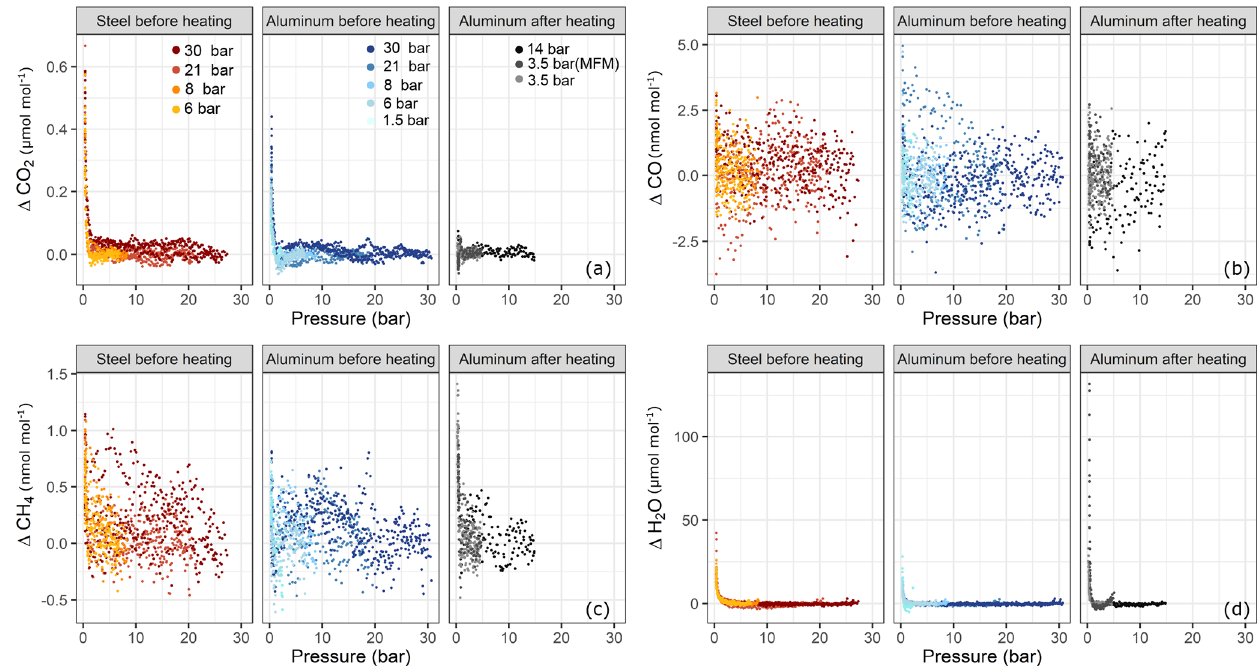
Figure 6. Amount fraction differences relative to the starting amount fractions during the course of each experiment with respect to pressure for (a) (cid:49) CO 2 , (b) (cid:49) CO, (c) (cid:49) CH 4 and (d) (cid:49) H 2 O. The subplots are grouped according to cylinder material and cylinder property: steel and aluminum before heating and aluminum after heating (Table 1b, f, h). Each subplot contains a set of pressure steps denoted by different colors. Each of the colored series comprises replicates at that corresponding pressure step. The x axes show the absolute pressure values in the sample cylinder.